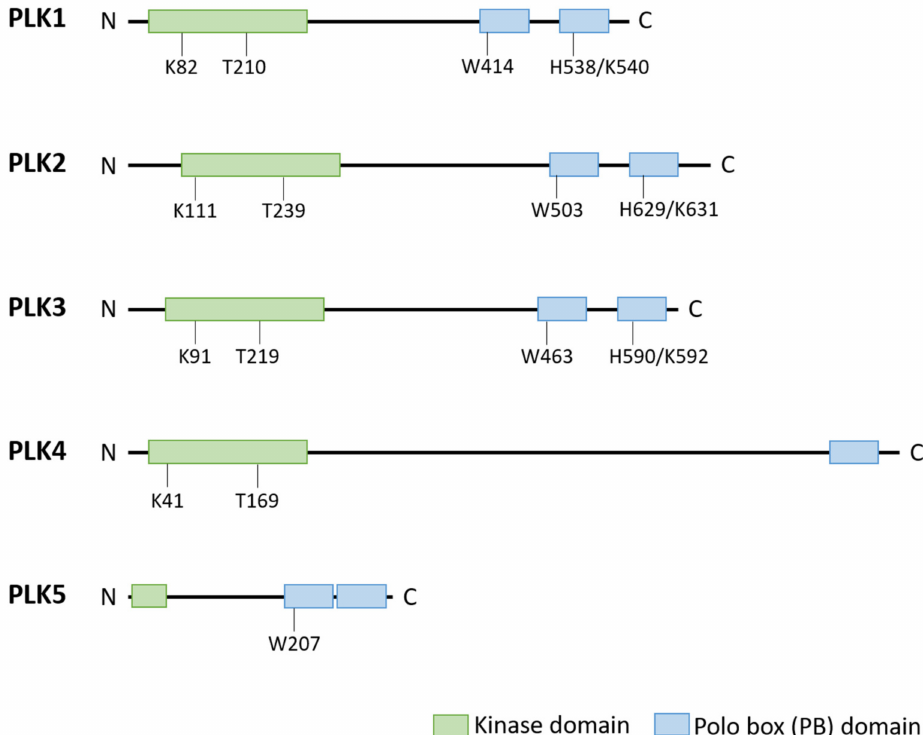
Figure 1. Structural differences between PLK family members PLK1–PLK5 [16]. PLK family members show a similar structure except PLK5. PLK1–PLK4 contain a highly conserved kinase domain at the N -terminal end and a non-catalytic polo box domain (PBD) at the C -terminus. The PBD is formed by three polo-boxes (PLK4) or two polo box motifs. These PBs are involved in substrate binding and regulation of kinase activity. Key residues of the kinase domain (acceptor lysine and T-loop threonine) and the PBs for substrate recognition are indicated. PLK5 has lost its catalytic activity in humans and expresses only a small portion of the kinase domain along with the PBD, the second PB has lost the conserved key residue involved in phosphosubstrate